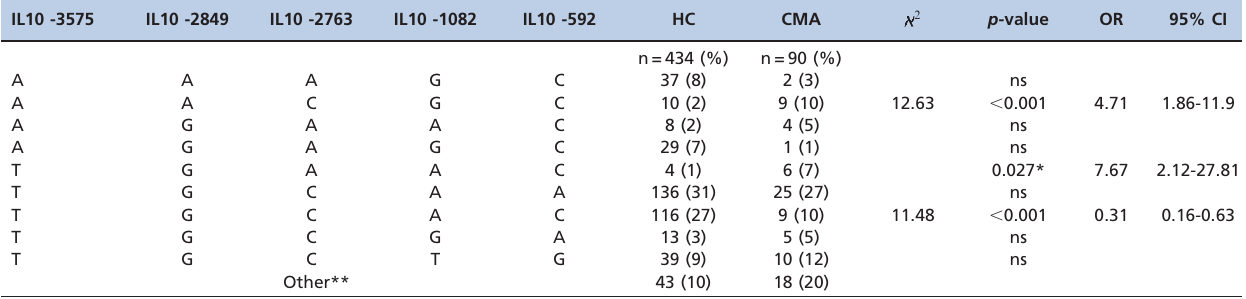
Table 3 - IL10 (-3575A/T, -2849A/G, -2763A/C, -1082A/G, -592A/C) haplotype frequency in children with cow’s milk allergy (CMA) and in healthy controls